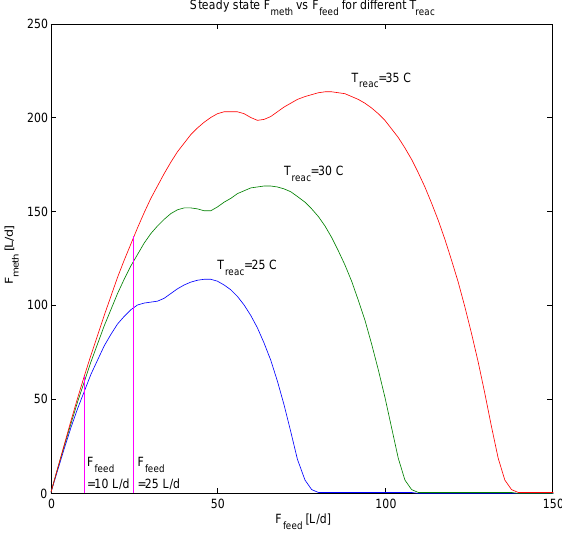
Figure 12: Steady-state F meth as a function of constant F feed for different T reac